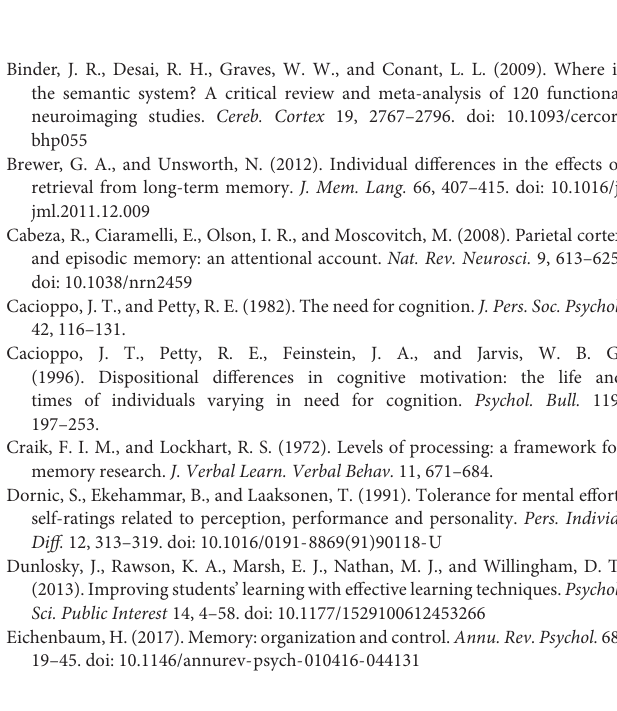
Supplementary Figure 1 | (A) The behavioral testing effect related to NFC group (high NFC and low NFC) reported in the article (i.e., Figure 3 ) along with an illustration of performance for the excluded intermediate NFC group (i.e., the 20% in the middle; patterned bars). Error bars denote ± 1 SEM., and (B) a plot for the association of each individual’s testing effect with their NFC score. Supplementary Figure 2 | The behavioral testing effect related to NFC group (high NFC and low NFC) and the different subsamples (classroom, fMRI). Error bars denote ± 1 SEM. ∗∗∗ p < 0.001. Supplementary Figure 3 | The overlap (yellow) in functional brain activity from the 2 × 2 ANOVA (main effect retrieval practice > study; red) and the group t -test controlling for performance differences (retrieval practice > study; green). For illustrative purposes, the effects are shown at a more lenient statistical threshold (uncorrected p < 0.0001 at the voxel level, and k > 10 at the cluster level). Supplementary Figure 4 | The main-effect of NFC group in the precentral gyrus [ − 48 4 32] at a more lenient statistical threshold (uncorrected p < 0.0001 at the voxel level, and k > 10 at the cluster level). Blue bars represent the retrieval practice condition. Red bars represent the study condition. Error bars denote ± 1